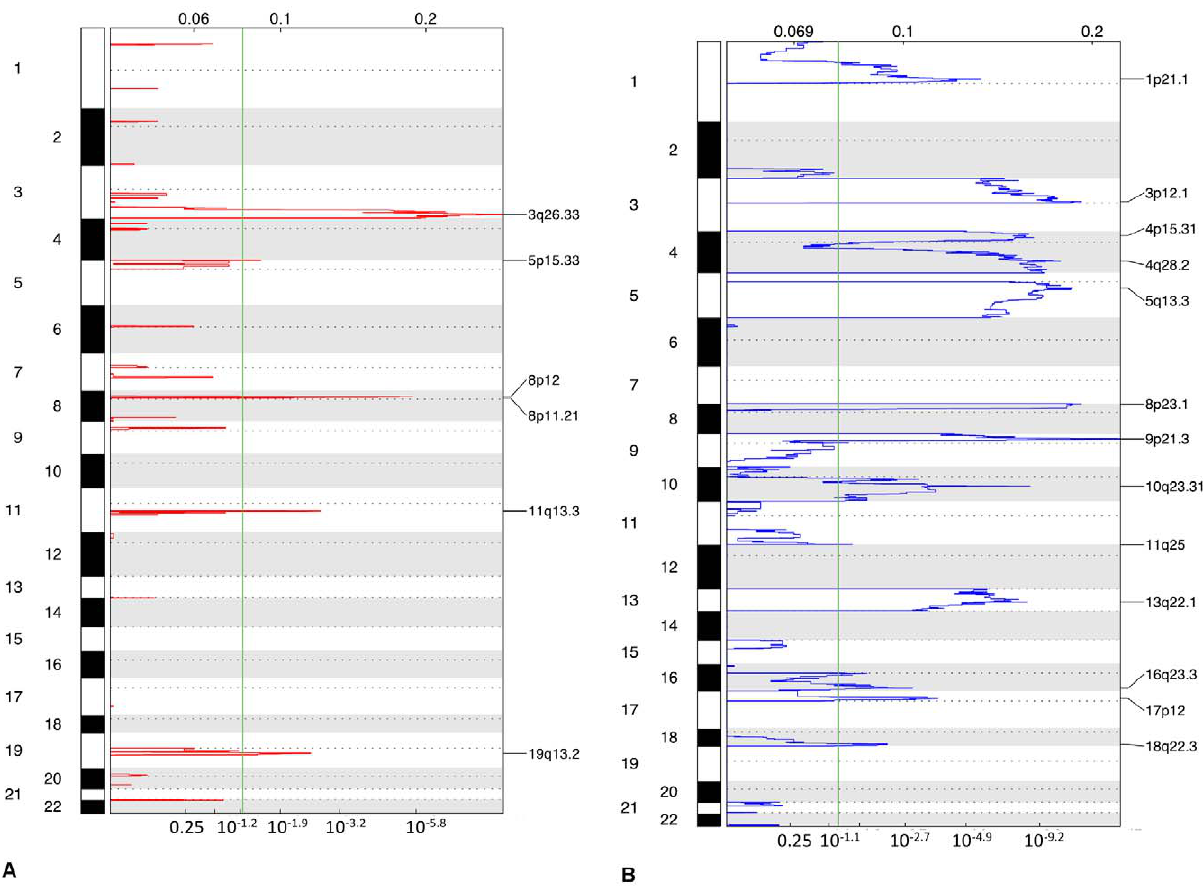
Figure 1. Genomic copy number alterations in lung squamous cell carcinomas. Plots of high-level amplifications (a) and deletions (b) in 62 lung SCCs from GISTIC analysis of aCGH data. X-axis shows the G score (top) and false discovery rate ( q value; bottom) with a green line demarcating a false discovery rate of 0.05. Labels on the right denote the peaks of the most significantly altered regions.